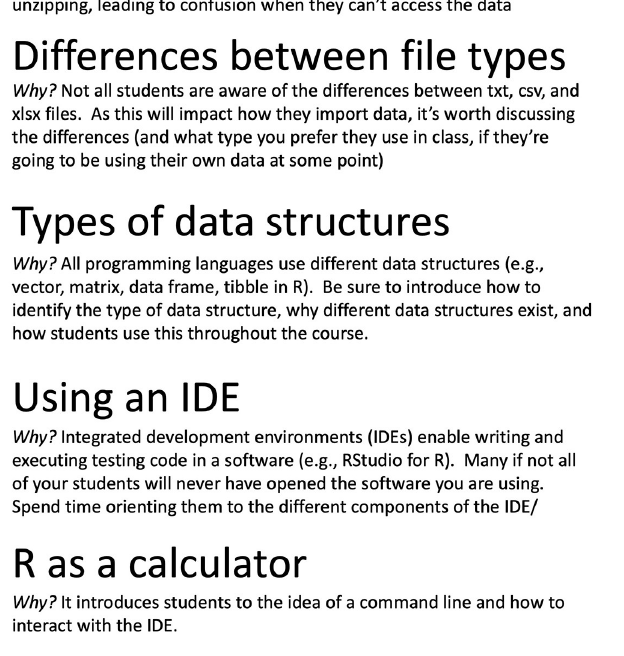
FIGURE 2 | Common oversights when first teaching students to